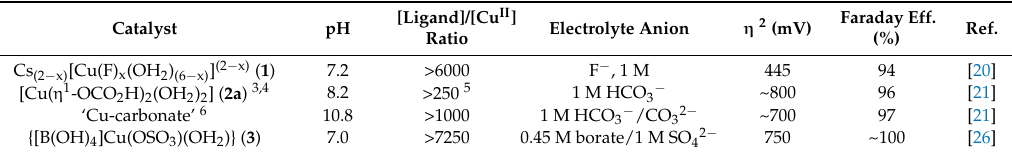
Figure 4. Proposed mechanism for the electrocatalytic oxygen evolving reaction by the ternary complex 3 [26].